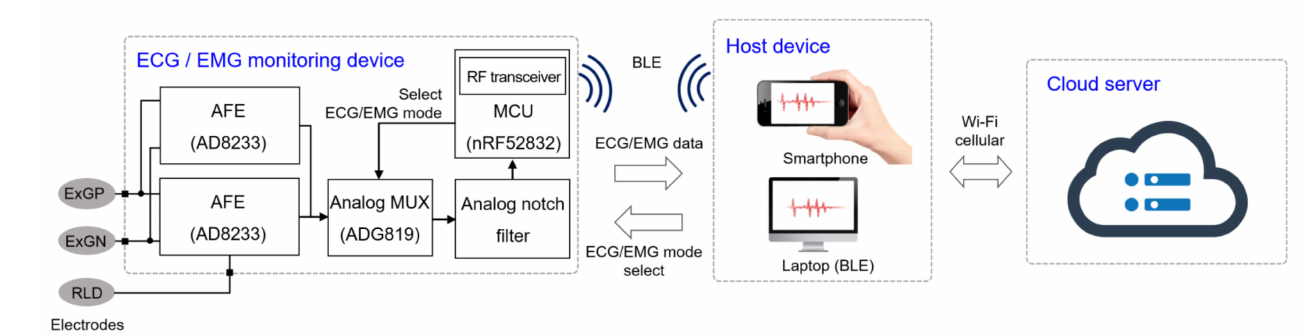
Figure 1. Block diagram of the monitoring system. The biopotentials are acquired from the electrodes and amplified by the analog front-end (AFE). The analog signals are sampled and wirelessly trans- mitted to the host device, where the signal is reconstructed in real-time for monitoring. This data are saved in the local device and stored in a cloud server via Wi-Fi or cellular